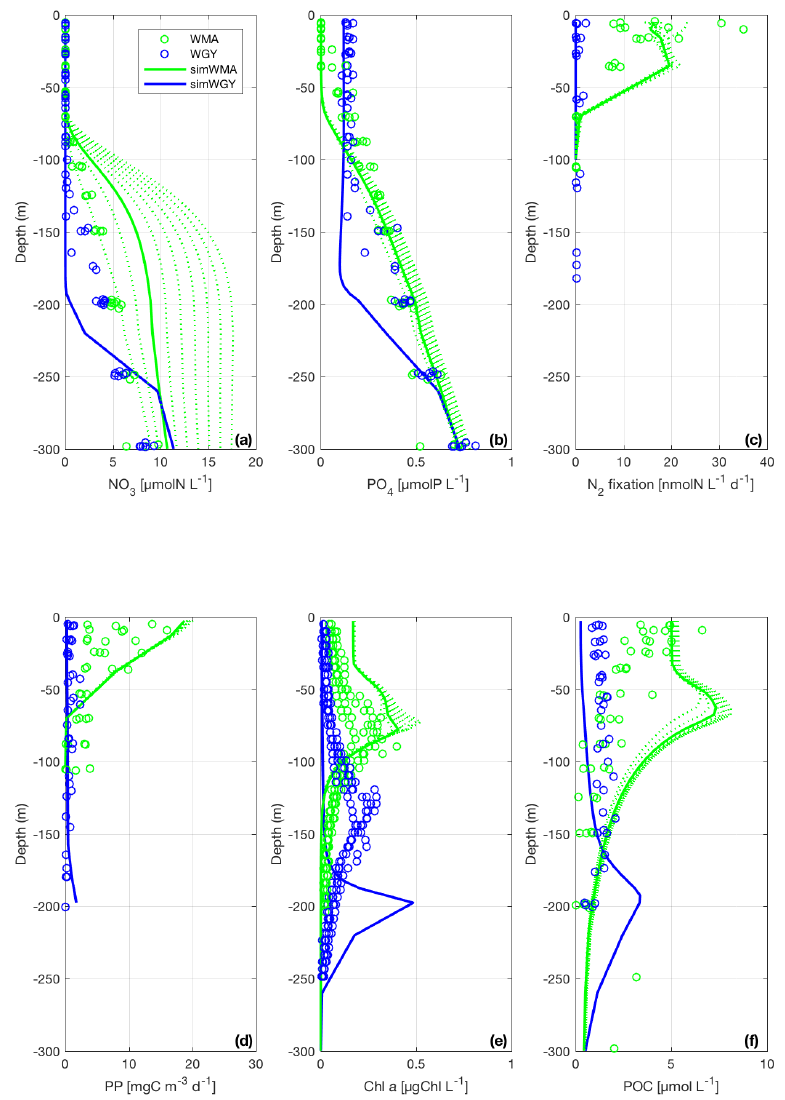
Figure 3. Vertical profiles of (a) dissolved inorganic nitrogen (DIN), (b) dissolved inorganic phosphorus (DIP), (c) N 2 fixation rates, (d) primary production (PP), (e) chlorophyll a (Chl a ) and (f) particulate organic carbon (POC) during the OUTPACE cruise in the WMA region (green circles) and in the WGY region (blue circles), and from the model results of the simulation with diazotrophy as a proxy of the WMA region (sim WMA , green line) and without diazotrophy as a proxy of the WGY region (sim WGY , blue line). For the sim WMA , we represent the profiles of the 10 years of simulation (dashed lines) to show the influence of the diazotrophy in the system.